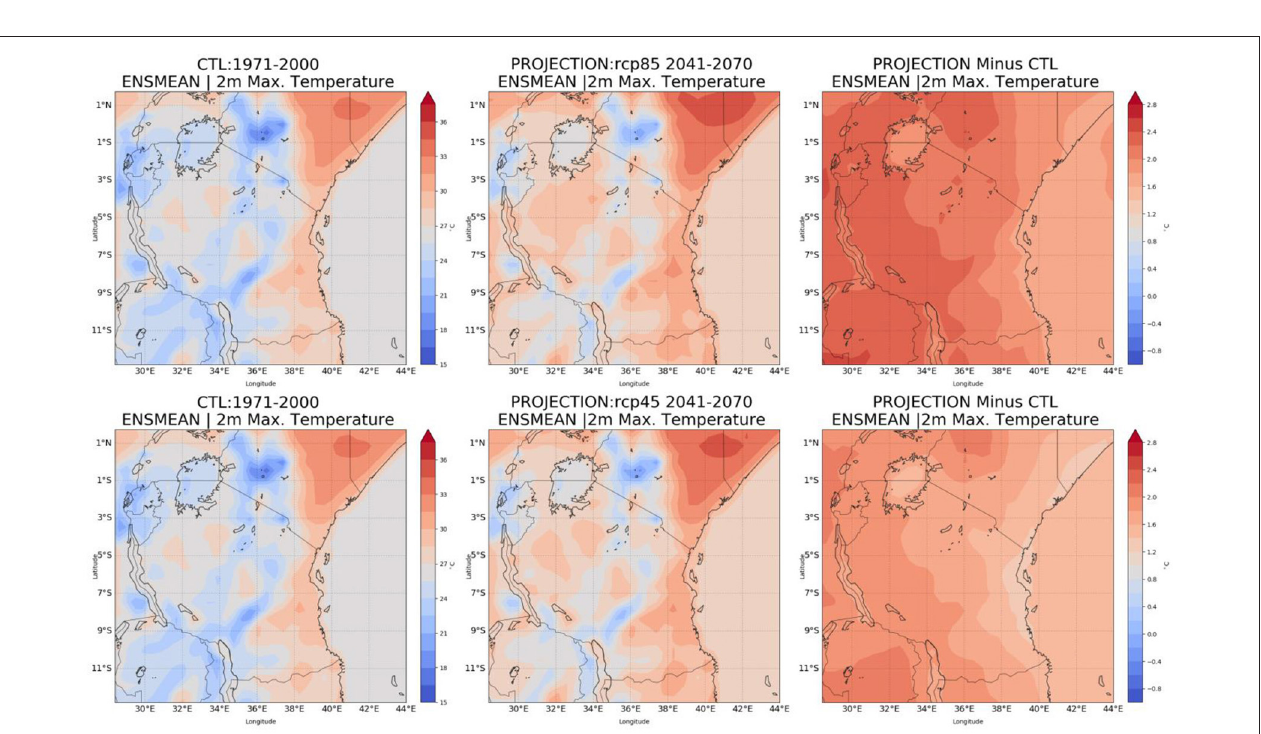
FIGURE 4 | The average of maximum temperature during base period (1971–2000), mid century (2041–2070), and the change in temperature during mid century under both RCP8.5 (upper) and RCP 4.5 (lower) .